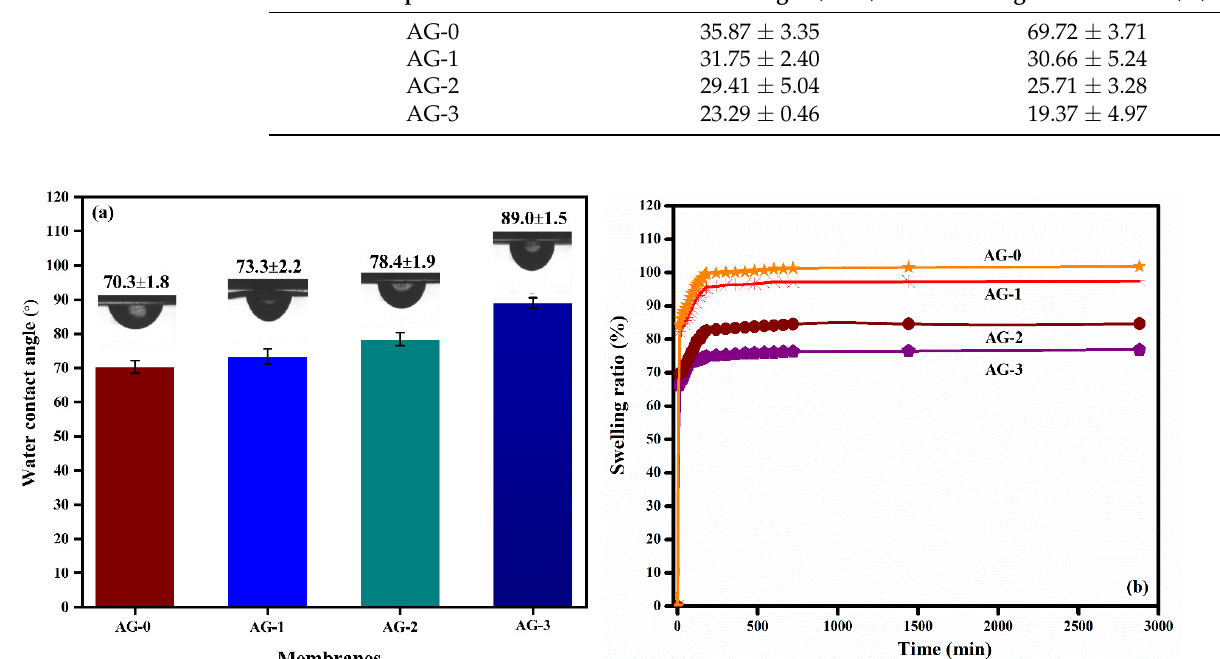
Figure 6. ( a ) Contact angles of droplets on agar/zeolite/CMC/PVA biomembrane and ( b ) swelling ratio with different time intervals of biomembrane based on agar/zeolite/CMC/PVA.